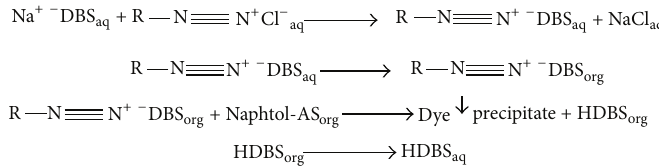
Scheme 2: RPTC mechanism for obtaining Naphthol AS-D